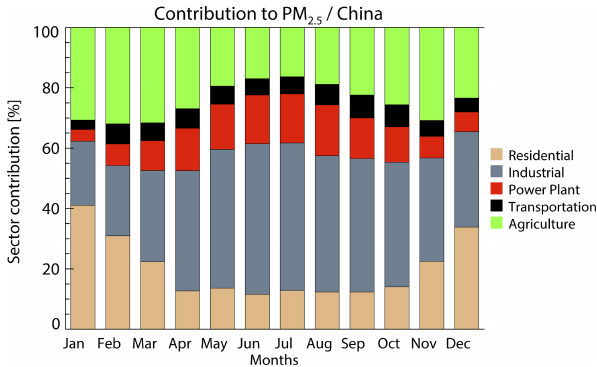
Figure 6. Monthly variations in emission contributions to surface PM 2 . 5 concentrations over China by sector. The contributions from the five sectors (residential, industry, power generation, transporta- tion, and agriculture) were estimated using a brute-force perturba- tion